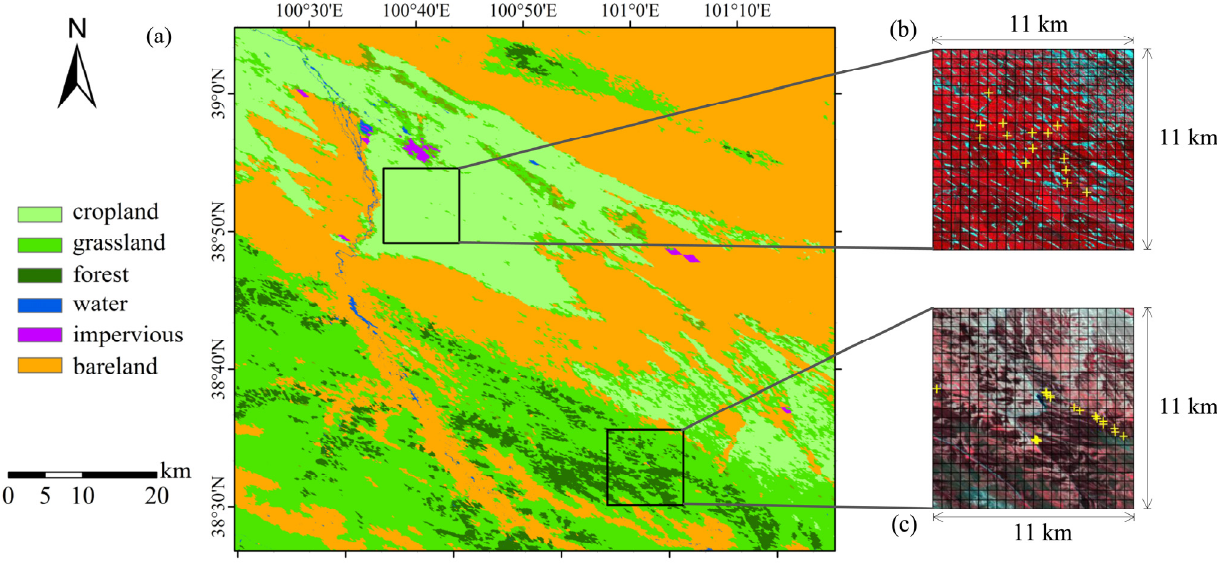
Figure 1. Land cover map of the upper and middle reaches of the Heihe River Basin in China ( a ) and the locations of the arid region experimental area (AREA) ( b ) and the forest experimental area (FEA) ( c ) sub-regions. The land cover map was downloaded from [55]. (b,c) False color images of ASTER/ETM+ acquired on 10 July 2012 and 28 May 2008, respectively. The black boxes and yellow crosses in (b) and (c) display the MODIS 500-m grids and field sampling